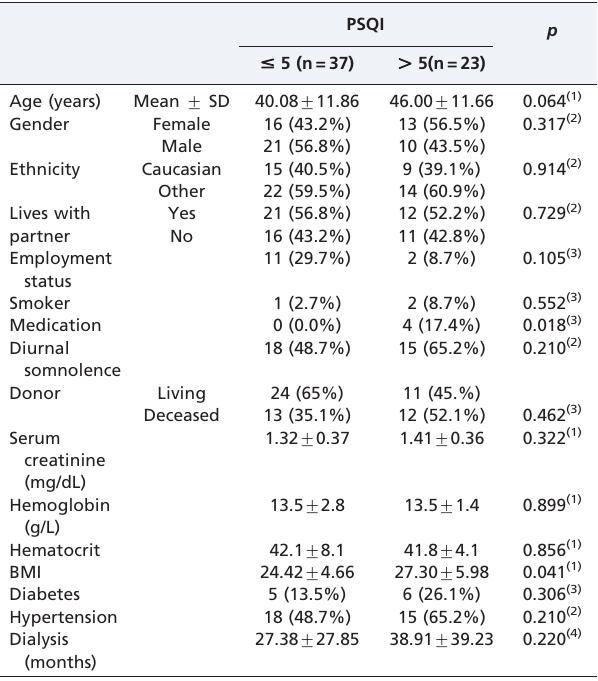
Table 3 - Clinical and social characteristics versus sleep quality.